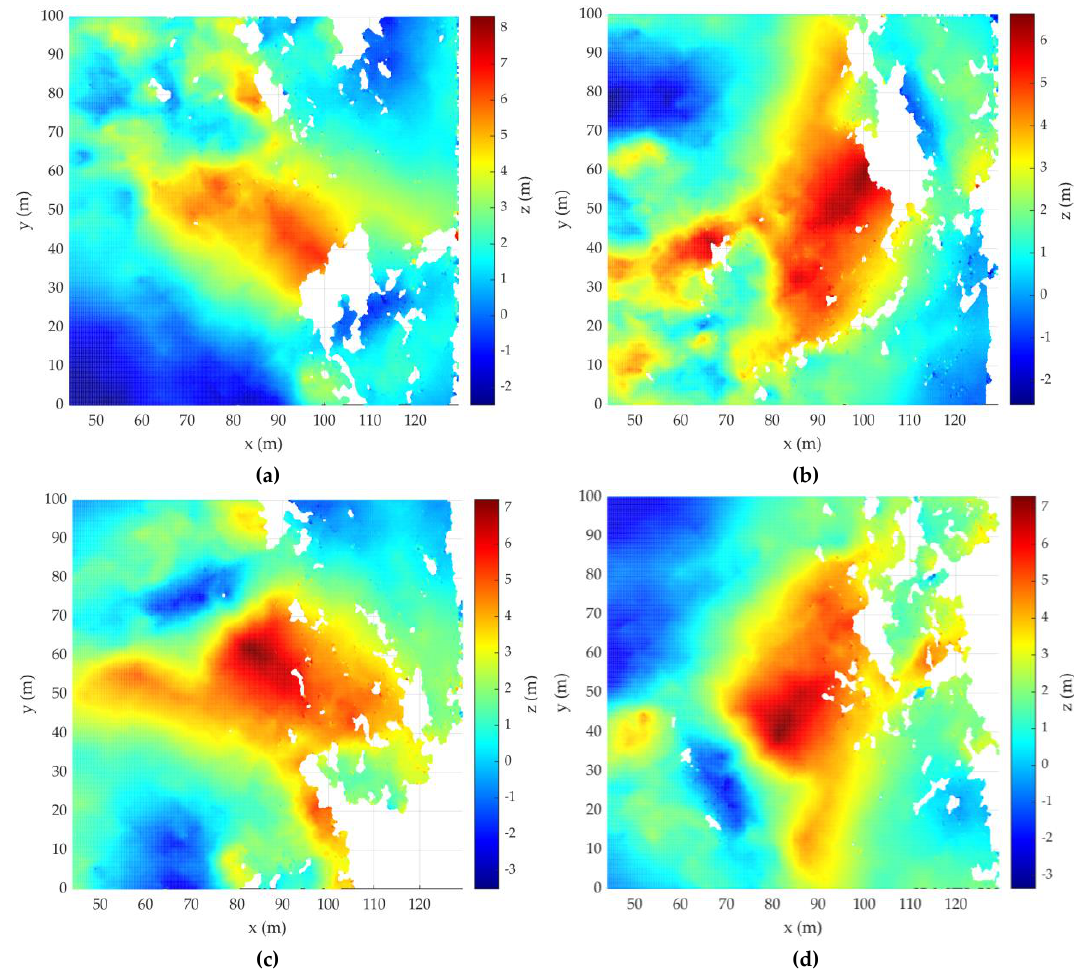
Figure 6. Estimation of DEM of (a) acquisition 1; (b) acquisition 2; (c) acquisition 3; (d) acquisition 4.